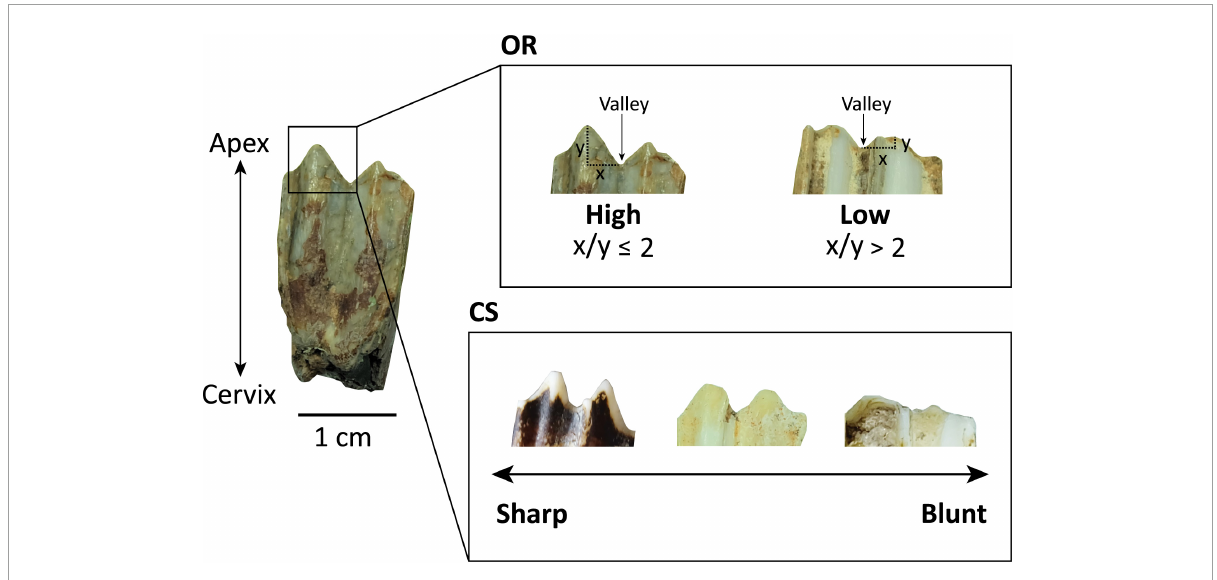
FIGURE2 Criteria of occlusal reliefs (OR) and cusp shapes (CS) for caprine teeth based on the mesowear II method.